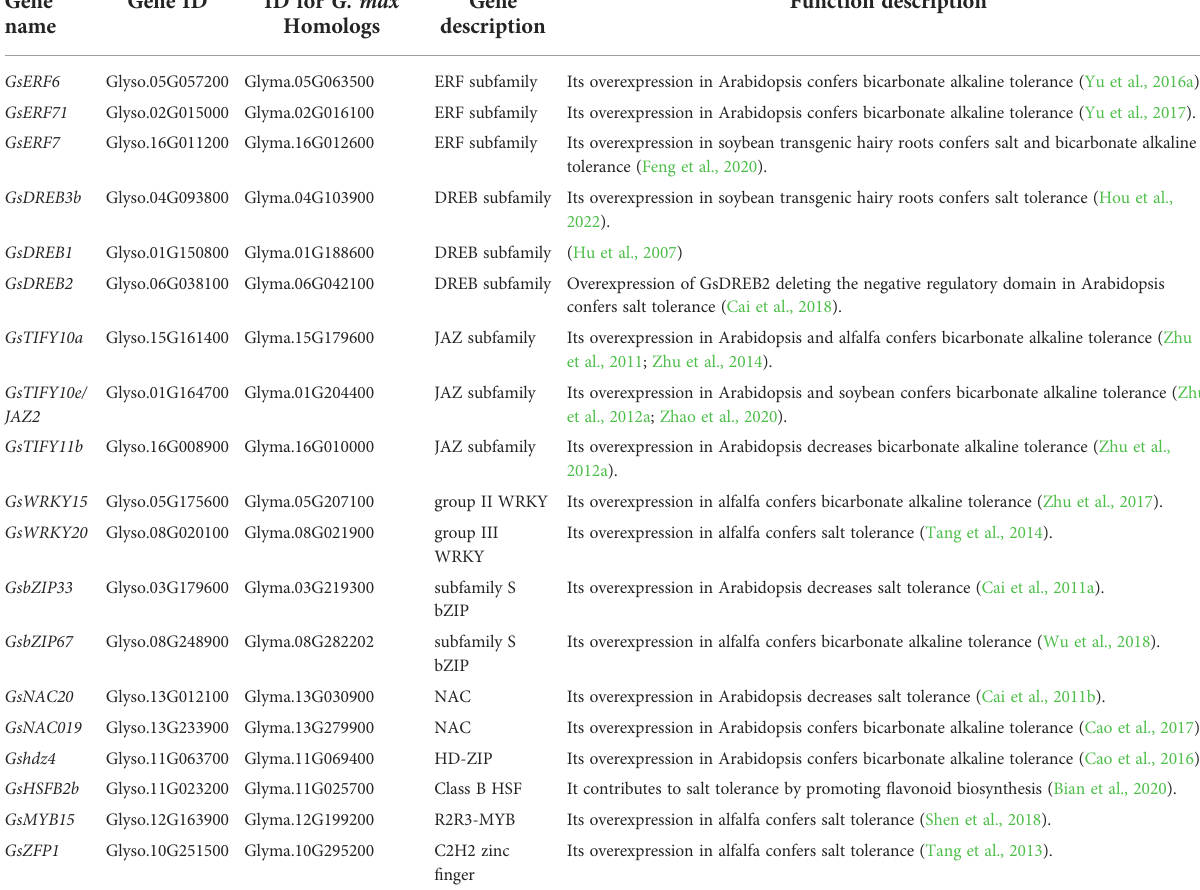
TABLE 4 The genes encoding transcription factors involved in regulating salt-alkaline stress response in wild